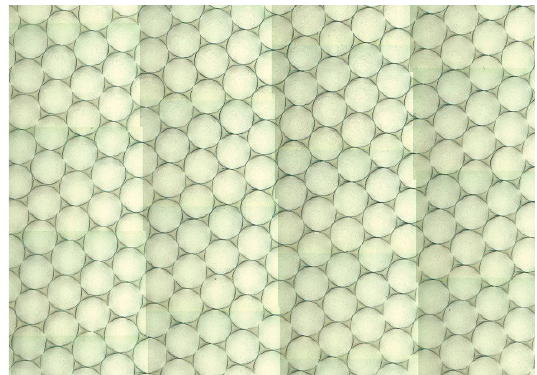
Figure 1. Portion of cross-section of WF/Zr-MG.